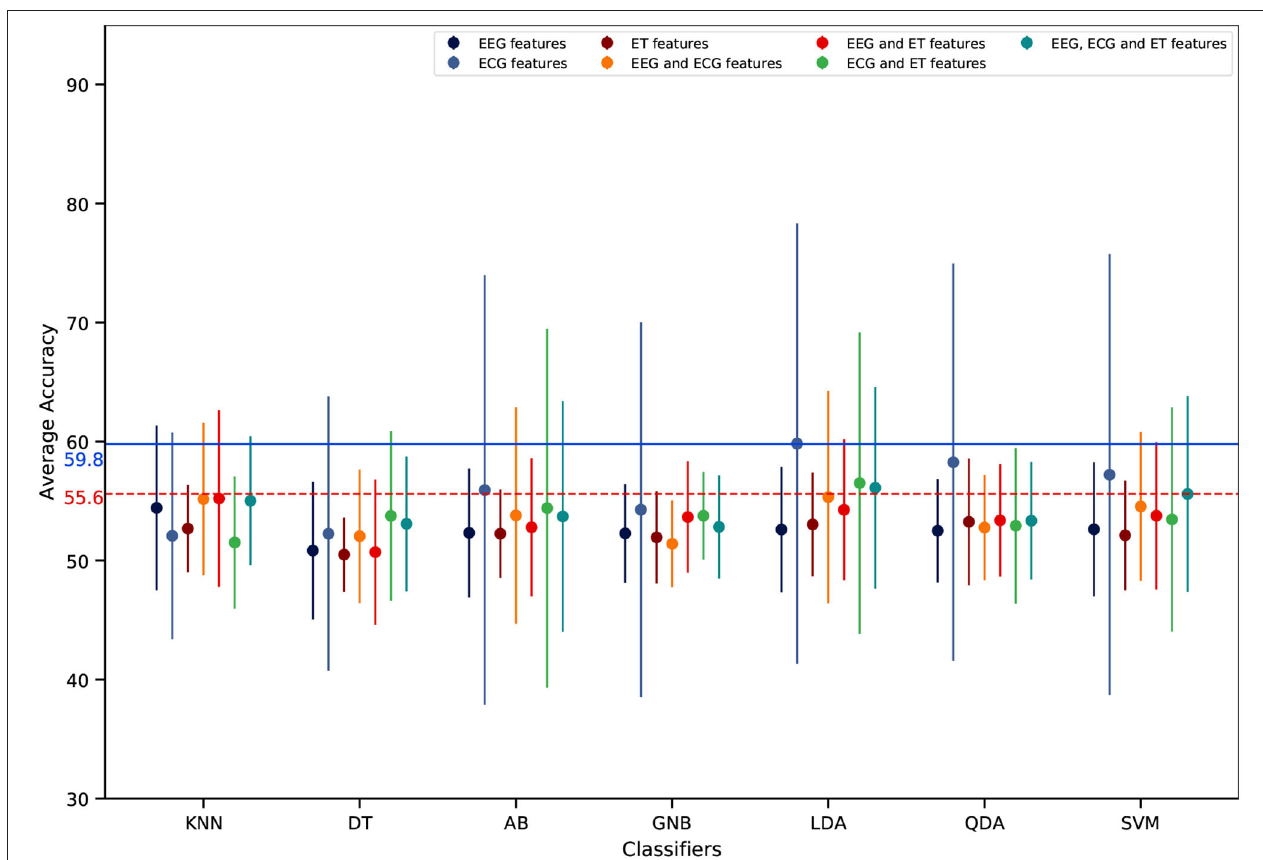
FIGURE 14 | Inter-subject mental workload estimation results per features and classifiers with the ecological validation design (average across participants). The dots represent the average score of each feature combination and the vertical line represents the associated standard deviation. The dashed horizontal red line represents the adjusted chance level while the blue one represents the highest classification